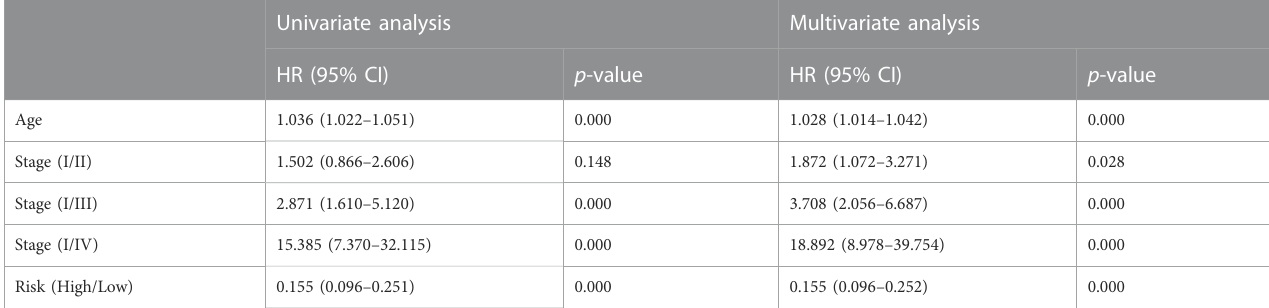
TABLE1 Univariate and multivariate Cox regression analysis of clinical characteristics and survival of BC patients in TCGA Cohort.